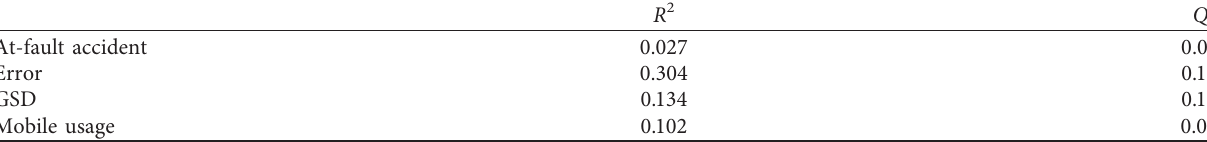
Table 3: R 2 and Q 2 results.